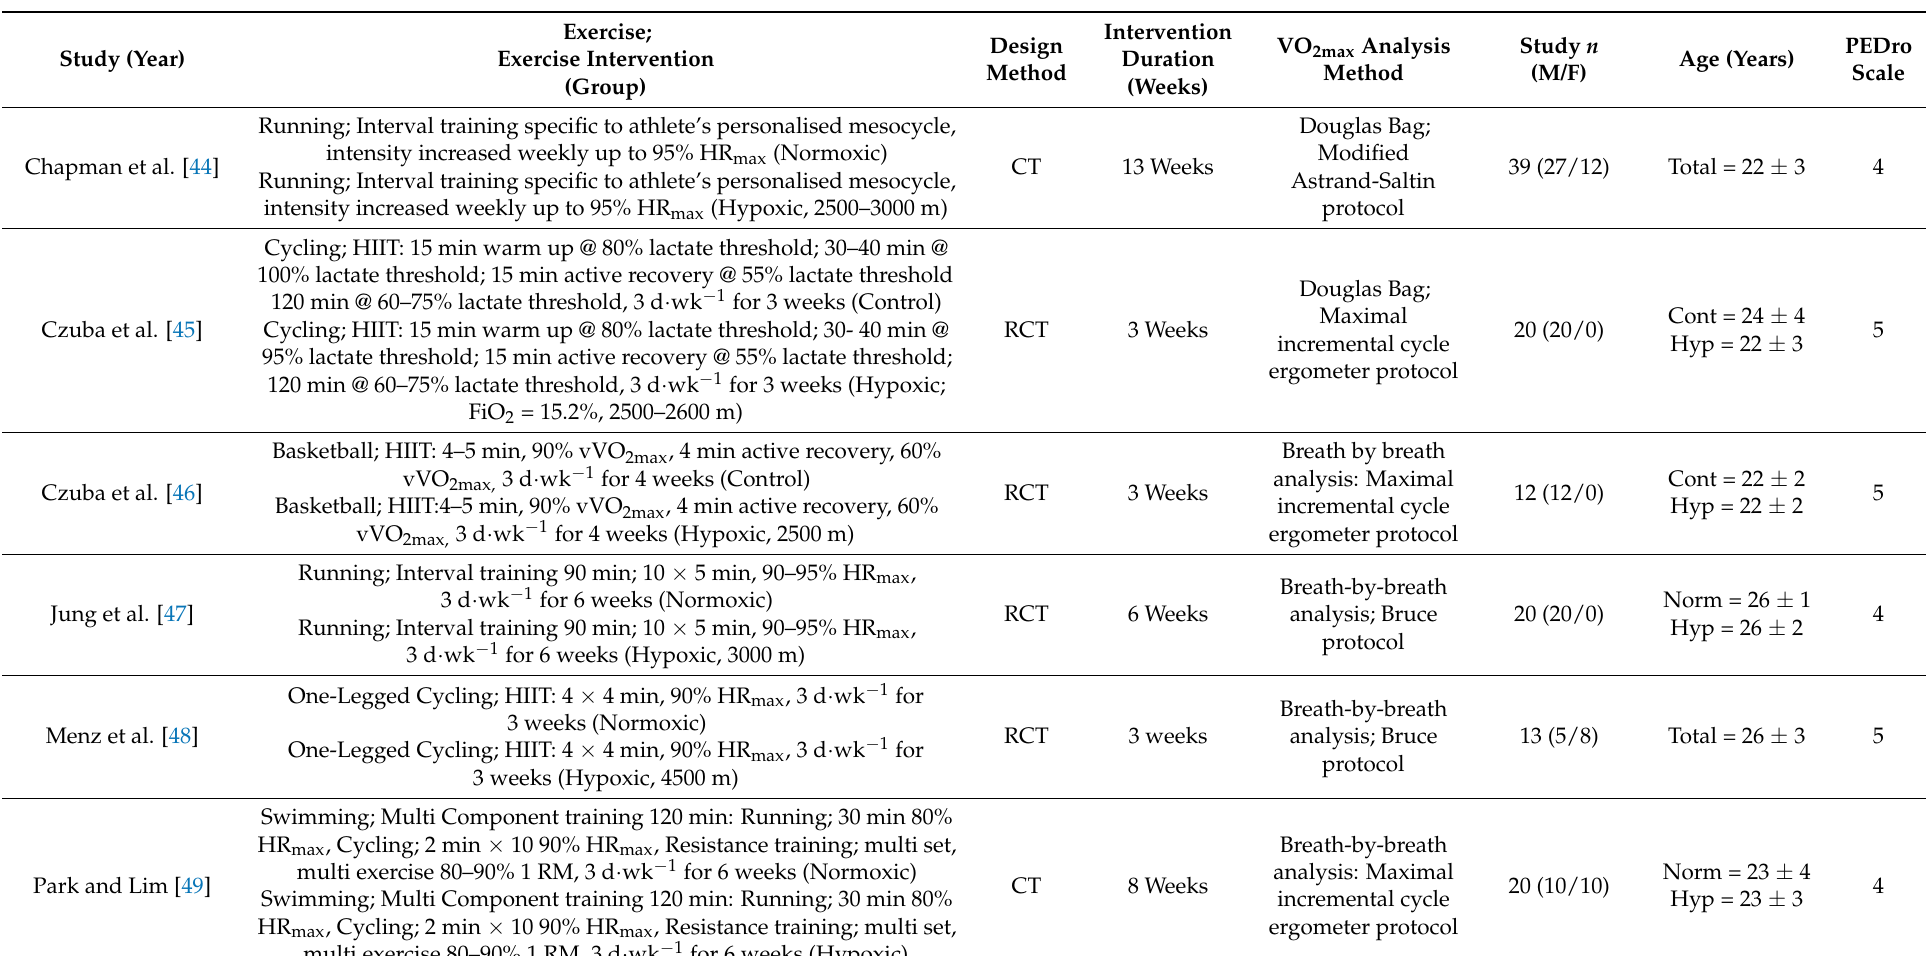
Table 1. Description of included data sets, including exercise intervention protocol, study design, and VO 2max analysis